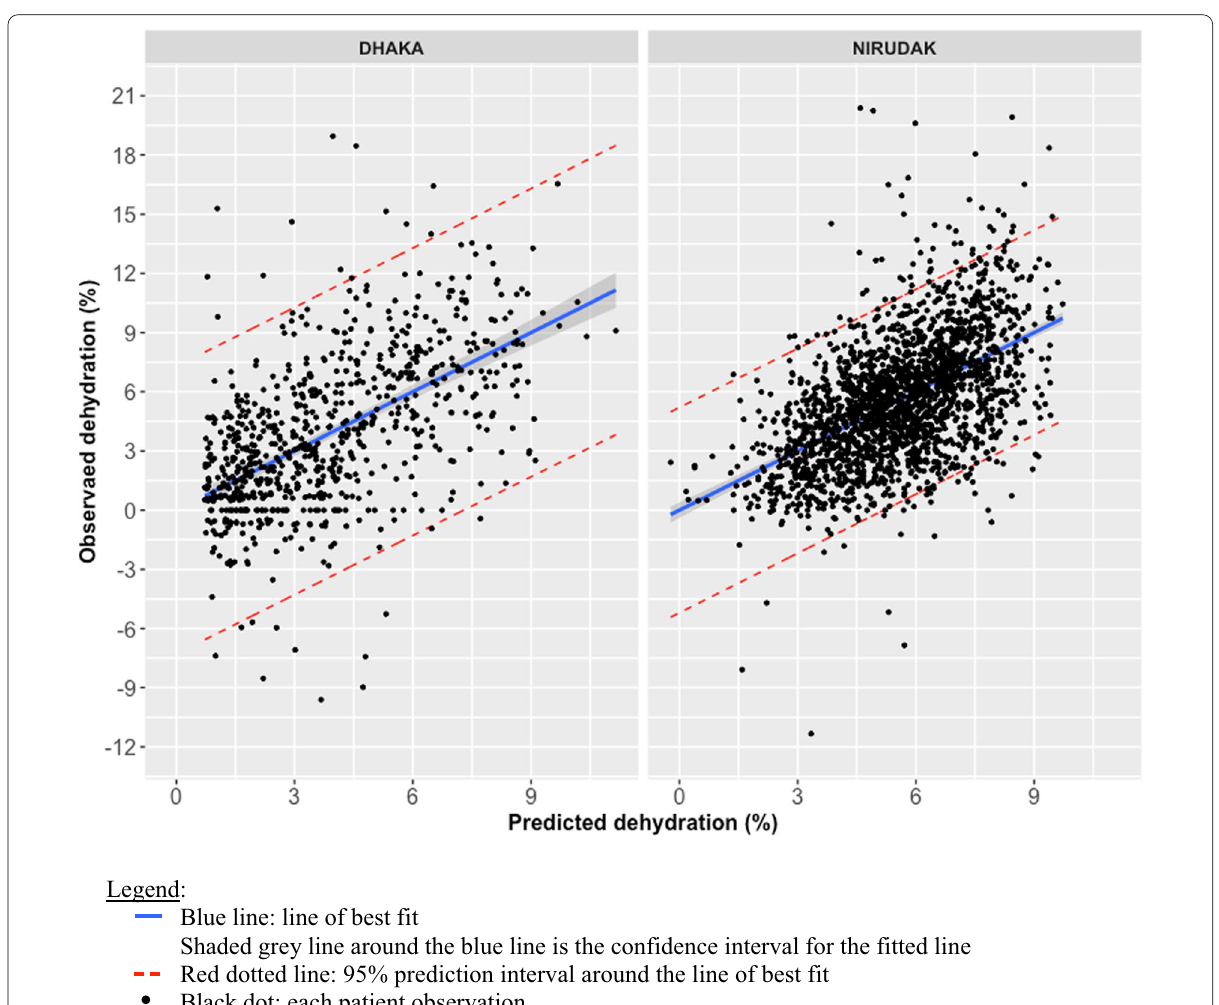
Fig. 3 Observed vs. predicted plot, DHAKA* and NIRUDAK